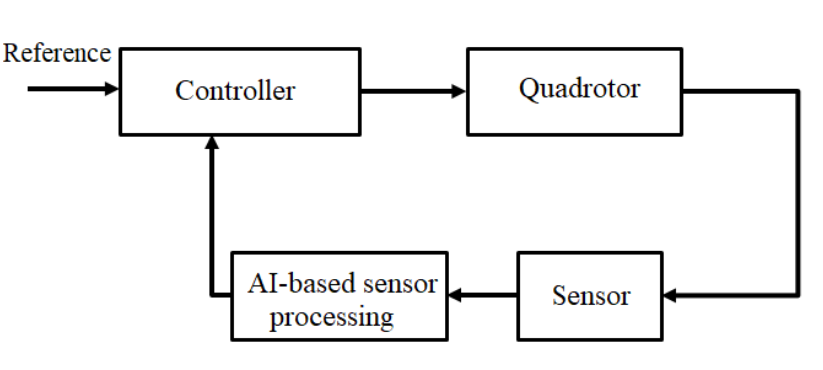
Figure 2. Architecture Overview of